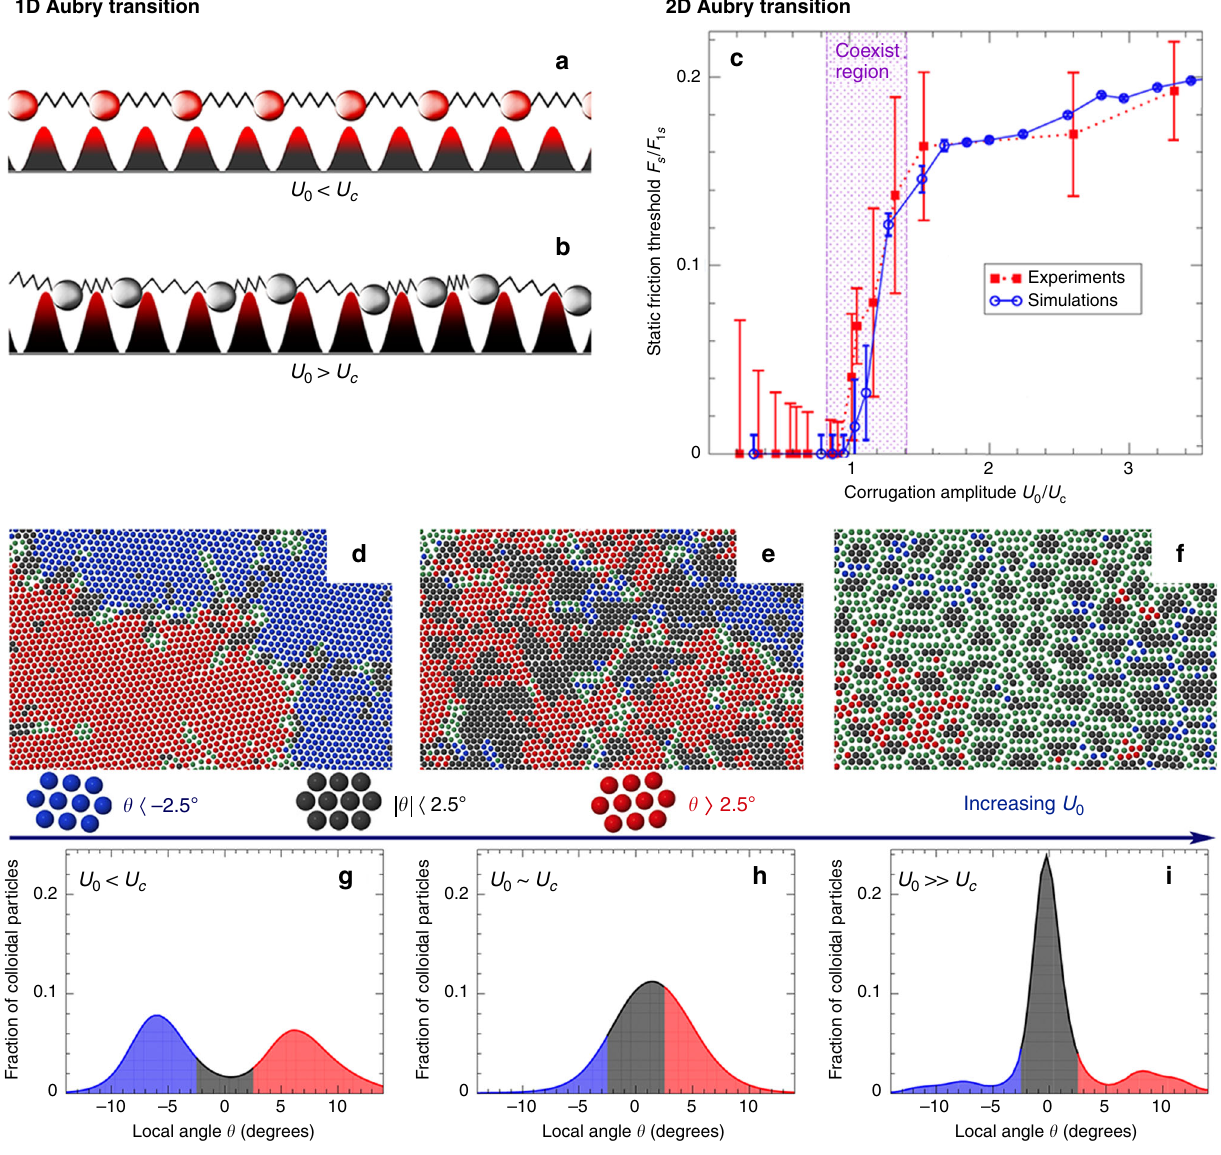
Fig. 6 Aubry transition in 1D and 2D systems. a , b Schematic view of a 1D system of elastically interacting particles subjected to an incommensurate periodic substrate. a When the substrate corrugation amplitude U 0 is below a critical value U c , particles are found at any displacement relative to substrate minima which results in a superlubric state. b When U 0 > U c particles become localized near the potential minima. This leads to a continuous Aubry transition from a superlubric to a pinned state. c Static friction force versus substrate corrugation obtained from experiments (solid symbols) and simulations (open symbols) of a 2D colloidal system; the shaded area shows the coexistence region, across which the Aubry transition takes place. Measured colloidal particle con fi gurations for increasing substrate potential: d U 0 < U c , e U 0 ≈ U c , and f U 0 > U c . The color code corresponds to the local mis fi t angle θ of the particles relative to the substrate. g – i Mis fi t angle-distribution for increasing substrate potential indicating the coexistence between a suberlubric and a pinned state 53 in agreement with numerical simulations predicting a fi rst-order Aubry transition in 2D 117,118